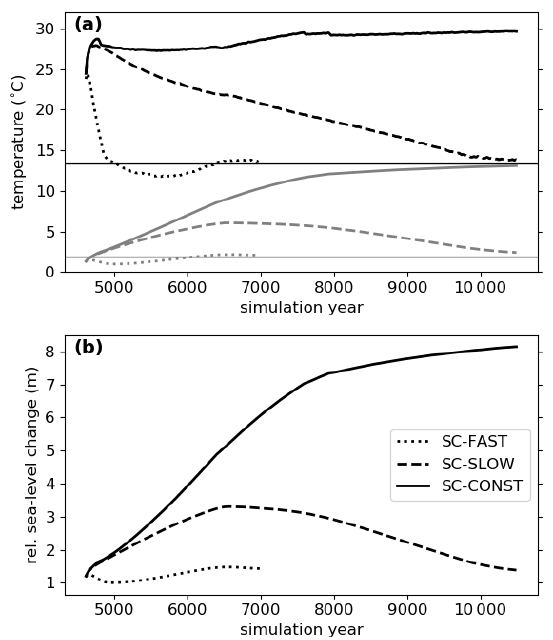
Figure 4. Temporal evolution of (a) global mean 2m air tempera- ture (black), ocean mean potential temperature (grey) and (b) rel- ative sea-level change due to thermal expansion with respect to the starting point of each scenario. All plots show 30-year running means. The horizontal lines depict the value of the Marinoan control